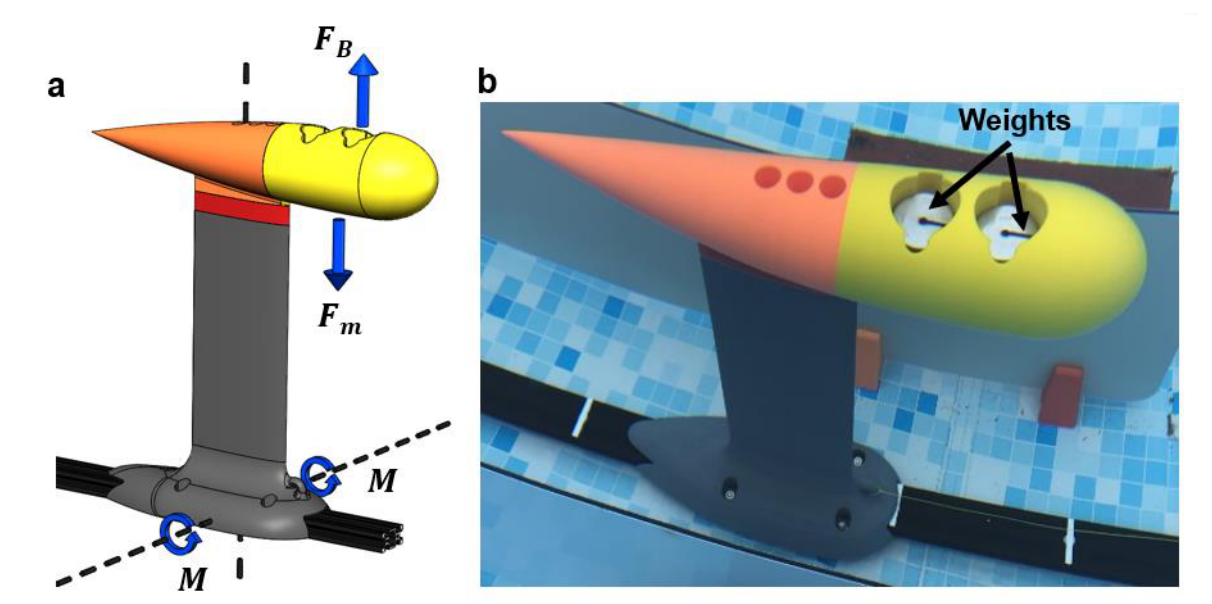
Figure 4. Normal load sensitivity study. ( a ) Calibration device schematic with F B = 8.085 N and F m = 0.981 n , where n is equal to the number of 100 g weights used. ( b ) Calibration device with six 100 g weights installed.